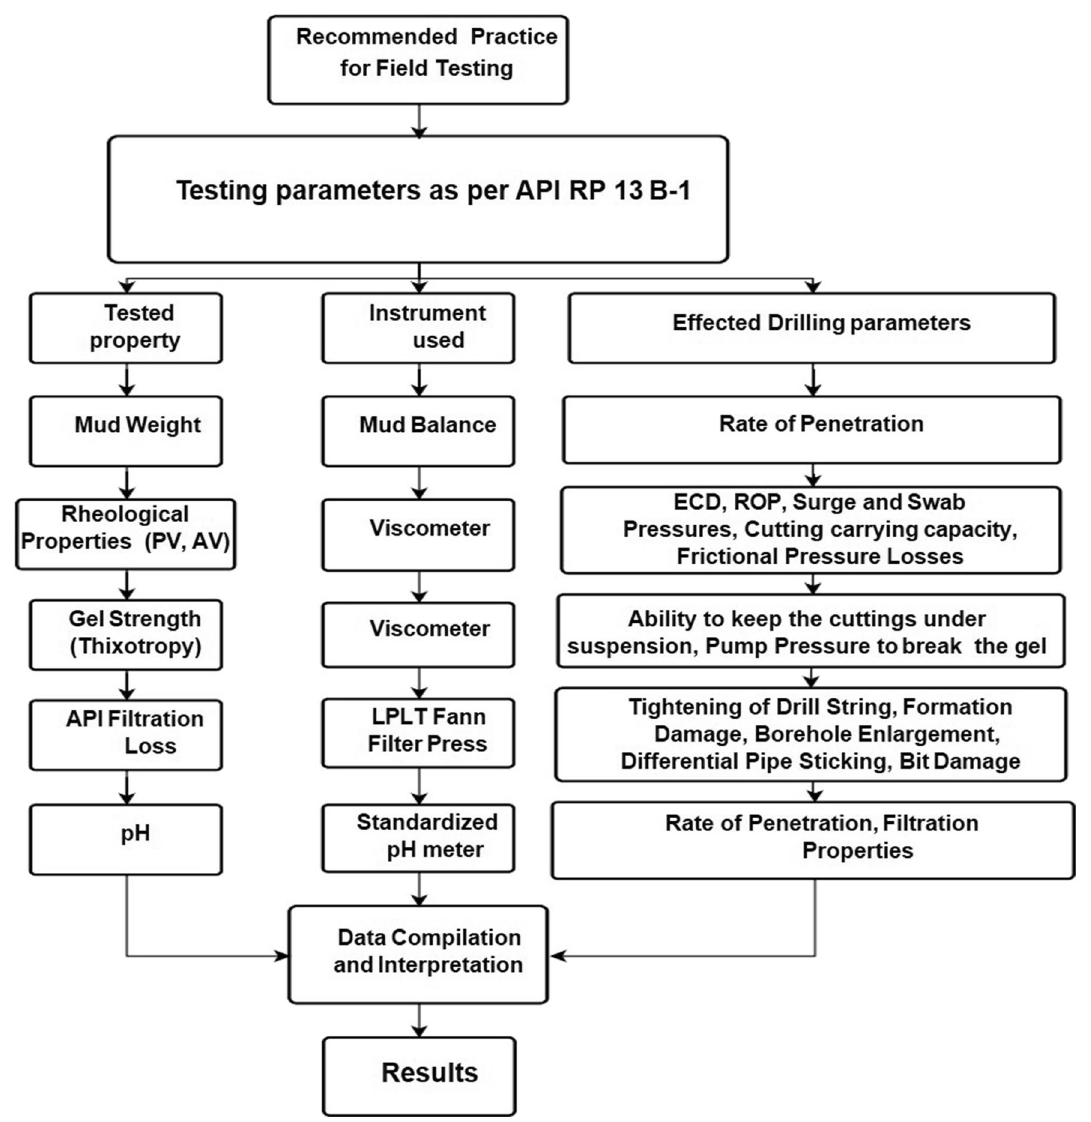
Fig. 1 Flowchart showing progressive methodology adopted and instruments used during current research